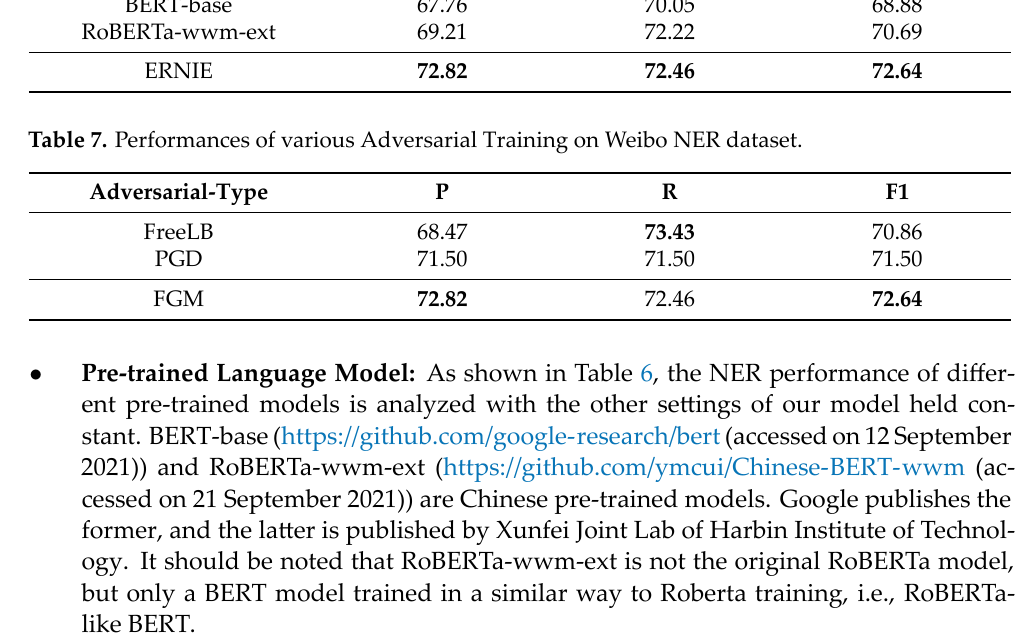
Table 6. Performances of various Pre‑trained Language models on the Weibo NER dataset. Pre‑Trained Model‑Type